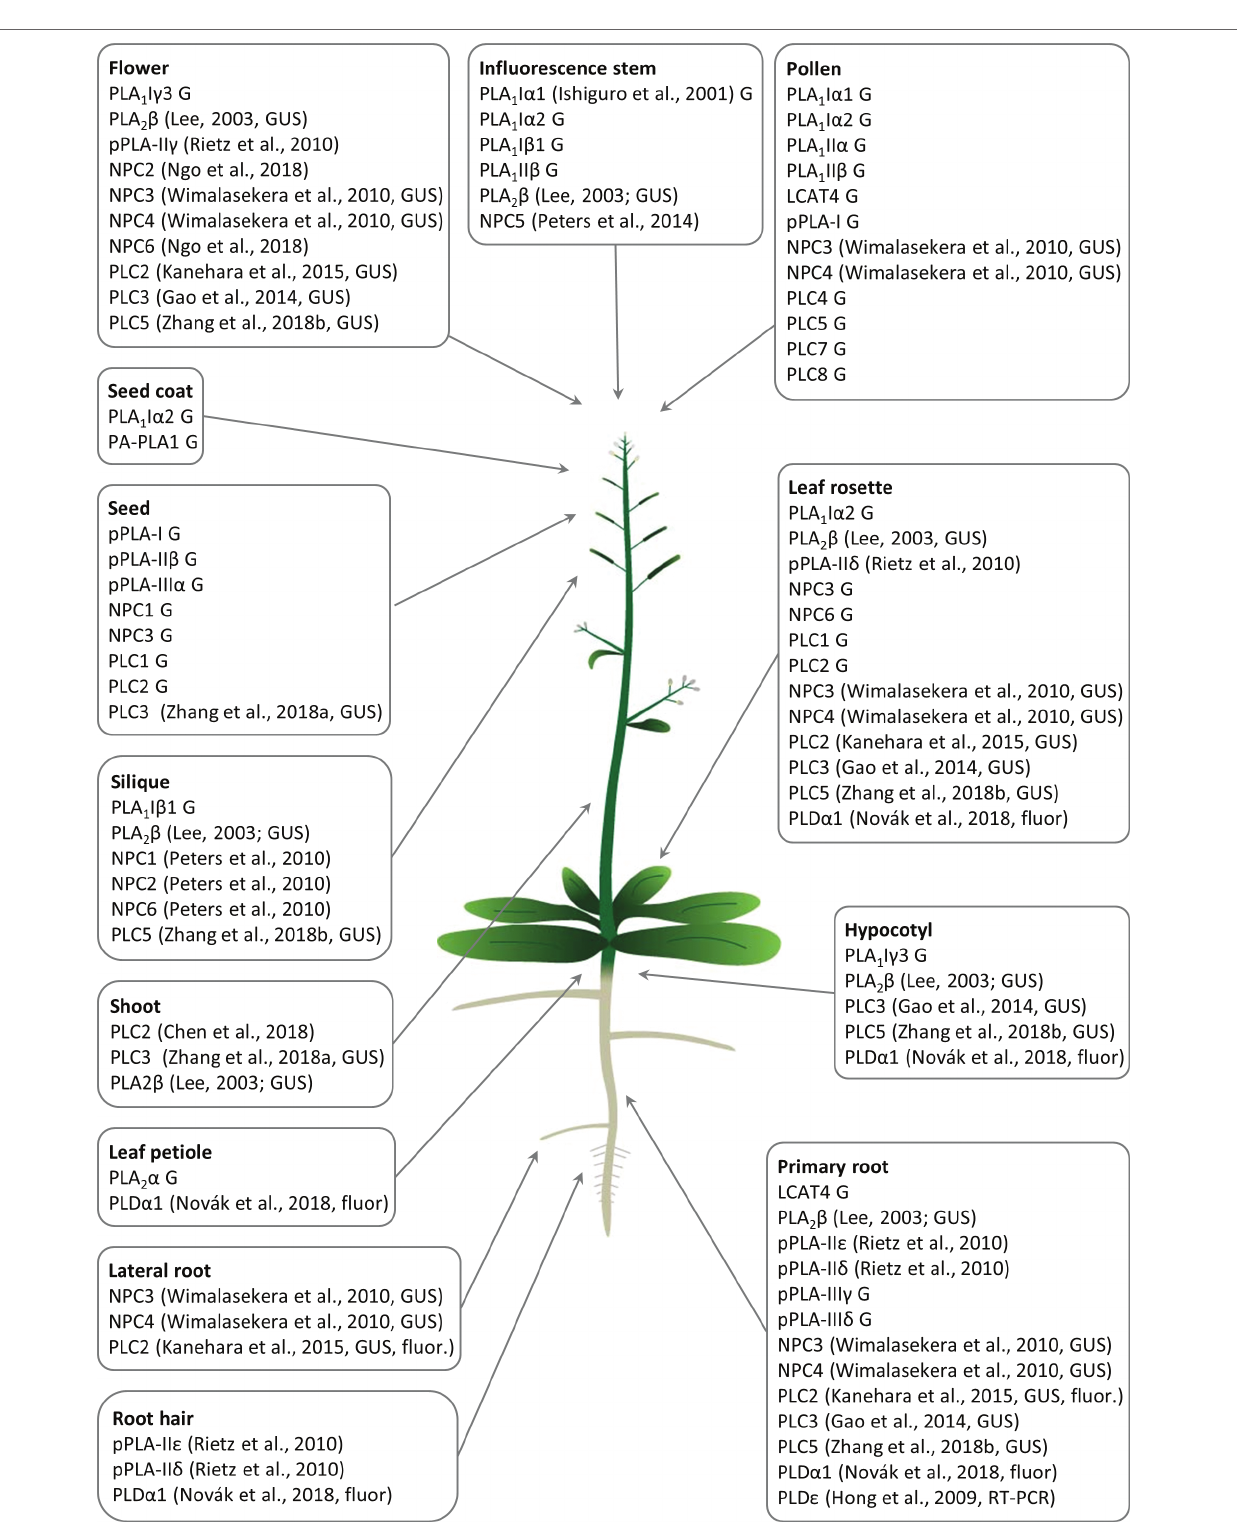
FIGURE 1 | Overview of Arabidopsis tissue- and organ-specific expression patterns and enrichment of diverse phospholipases important for the development of respective plant organs and tissues. G means that the gene expression data were retrieved from the Genvestigator database, GUS means that the expression data represented the results of promoter-GUS reporter gene assays, and fluor means that the expression data represented microscopic observations of fluorescently tagged phospholipases. Citations to the relevant original articles are